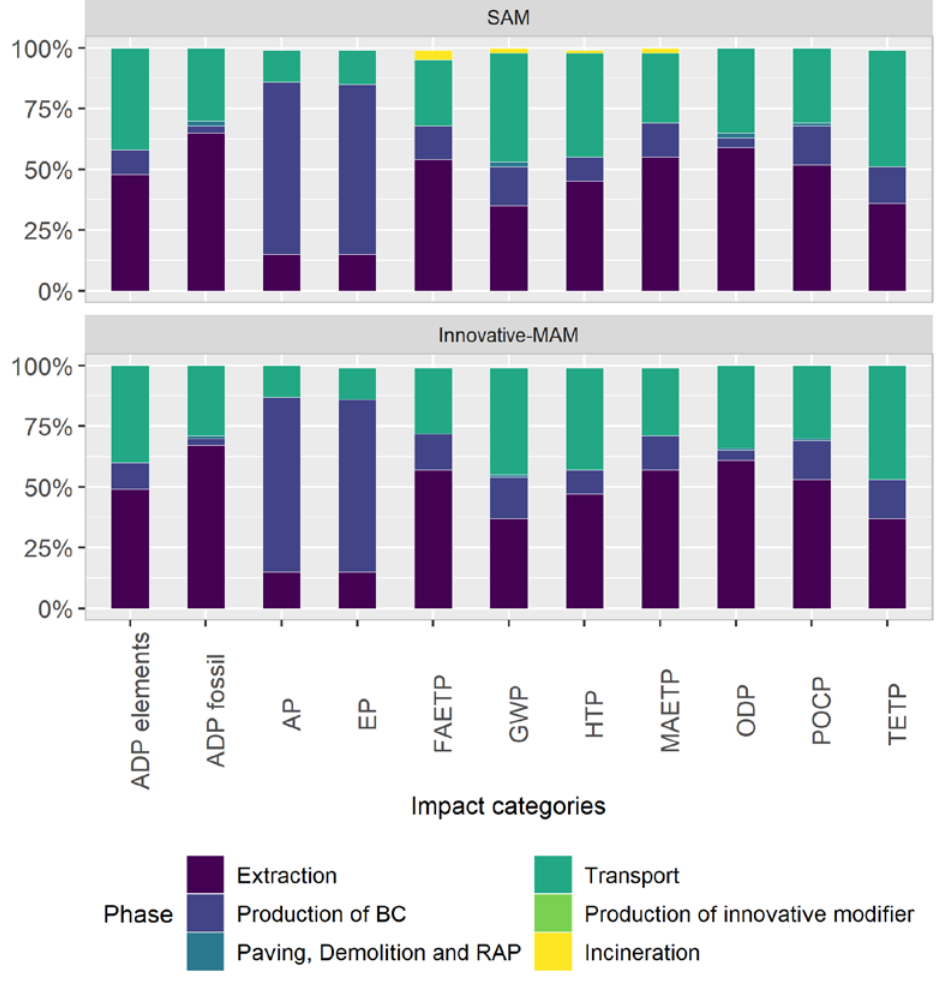
Figure 3. Analysis of the major contributions to environmental impacts provided by different processes referred to the conventional pavement (SAM) life cycle ( upper panel) and the pavement with the innovative modifier (MAM) life cycle ( lower panel).